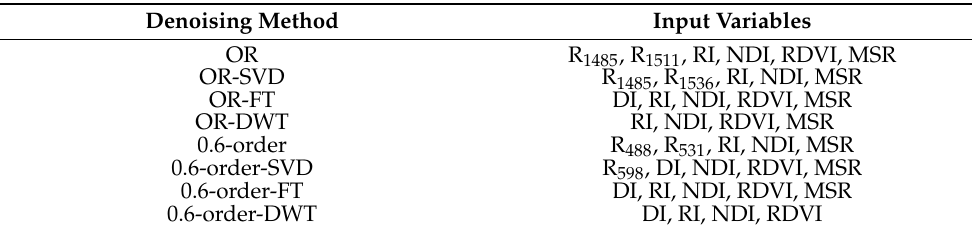
Table 4. Selection of the input variables based on the RFE method. Denoising Method Input Variables